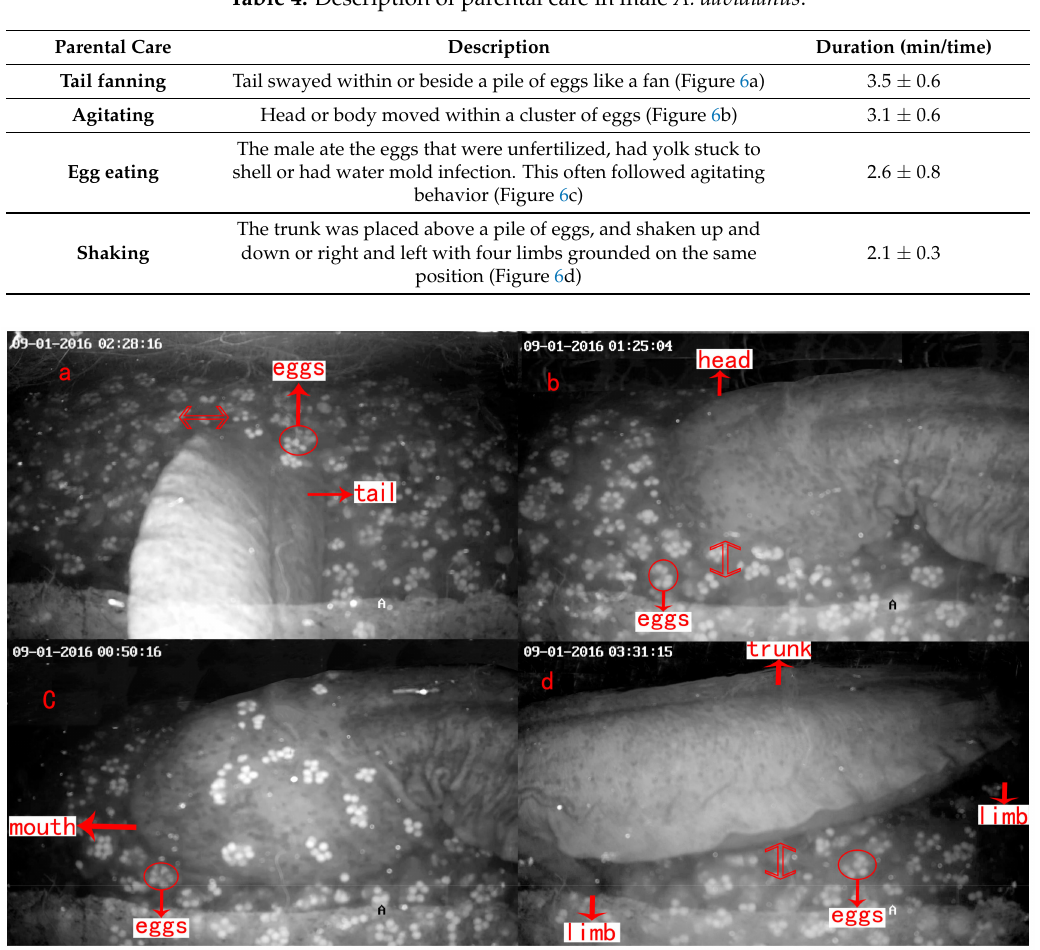
Figure 6. Parental care behavior in male A. davidianus : ( a ) tail fanning; ( b ) agitation; ( c ) egg eating; and ( d )